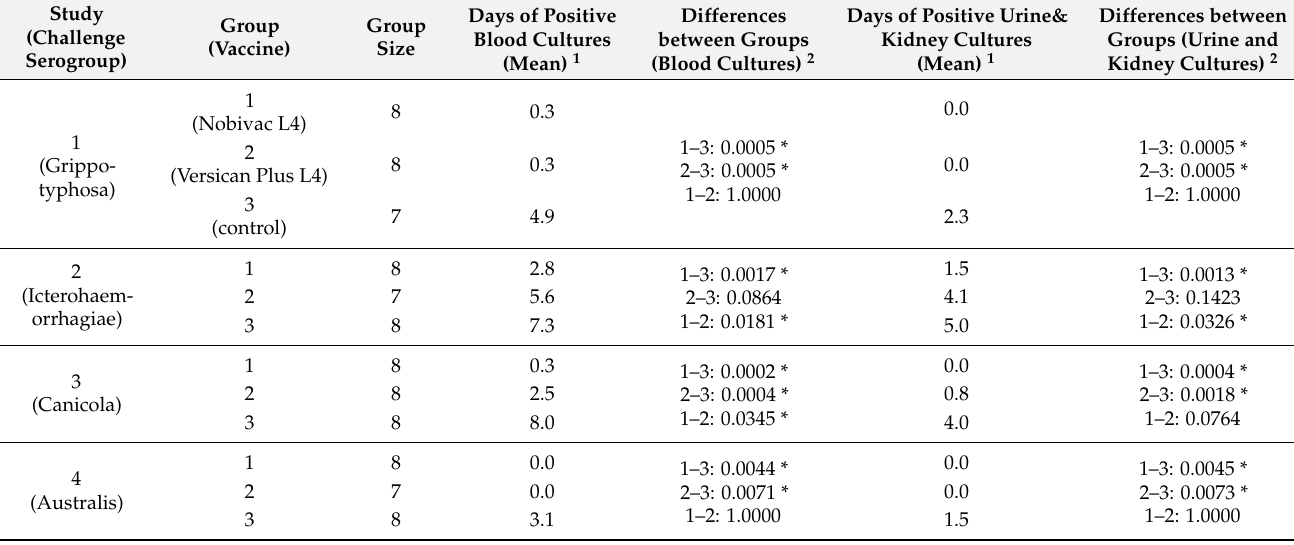
Table 3. Duration of bacteraemia and urinary